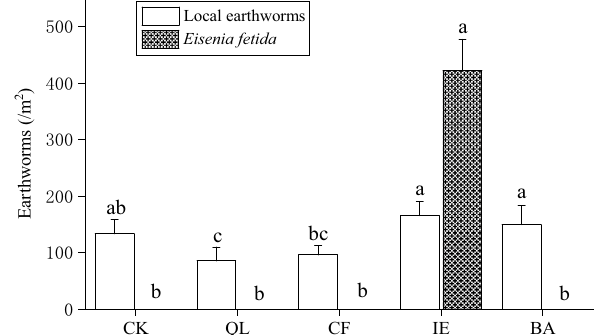
Figure 3. Effects of different treatments on the number of earthworms. Bars indicate standard error (n = 3). Different letters above columns within the same species indicate significance at p < 0.05 according to Duncan’s